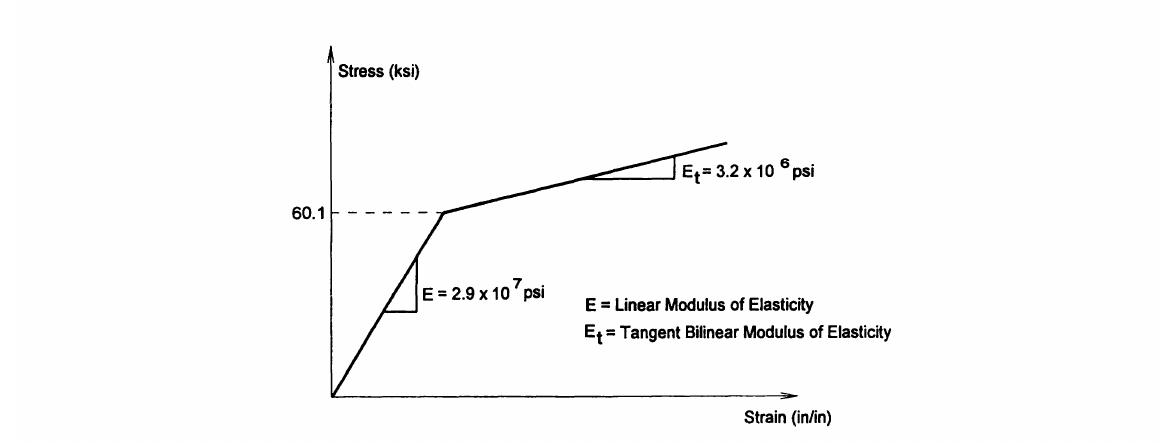
FIGURE 4 Stress-strain relation of SA-I06B carbon steel at